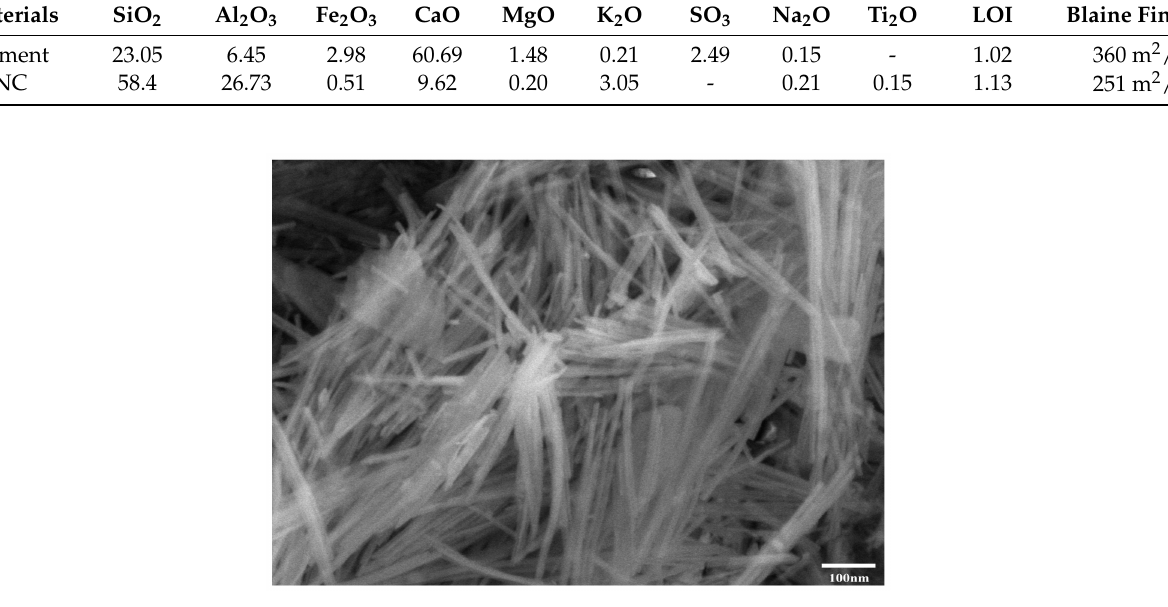
Figure 1. SEM of